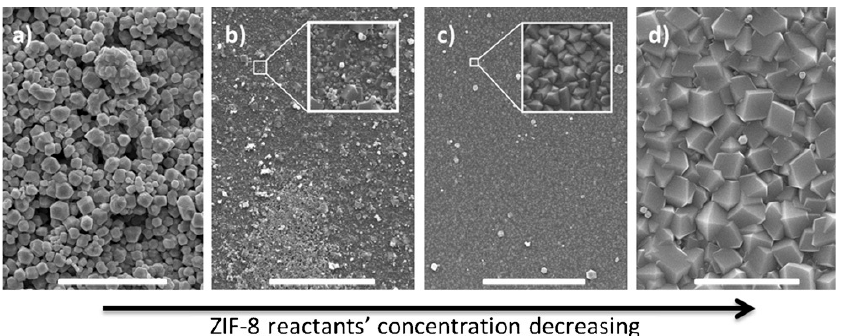
Figure 11. Structure of poly-thiosemicarbazide (adapted with permission from ref. [95]). Crystals 2018 , 8 , x FOR PEER REVIEW